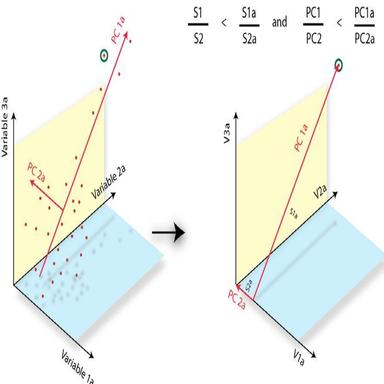
Action of PCA for a schematic dataset with many objects and three variables. (a) shows how the PCA reduces the data set to show strong variation along one principal axis, which may not be an axis of the initial data set; (b) shows how varying the weighting of two combined data sets, which present as information along different axes, can change the variance and therefore the separation of the data sets. Note that this is a simplified schematic for the purposes of visualisation, as our datasets contain tens o